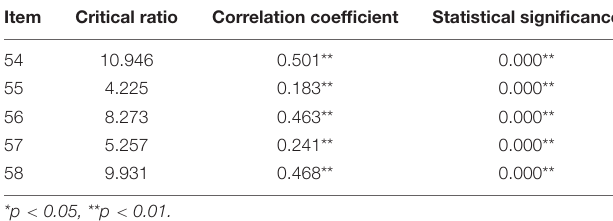
TABLE 5 | Item analysis results in Study 2 ( n = 447).